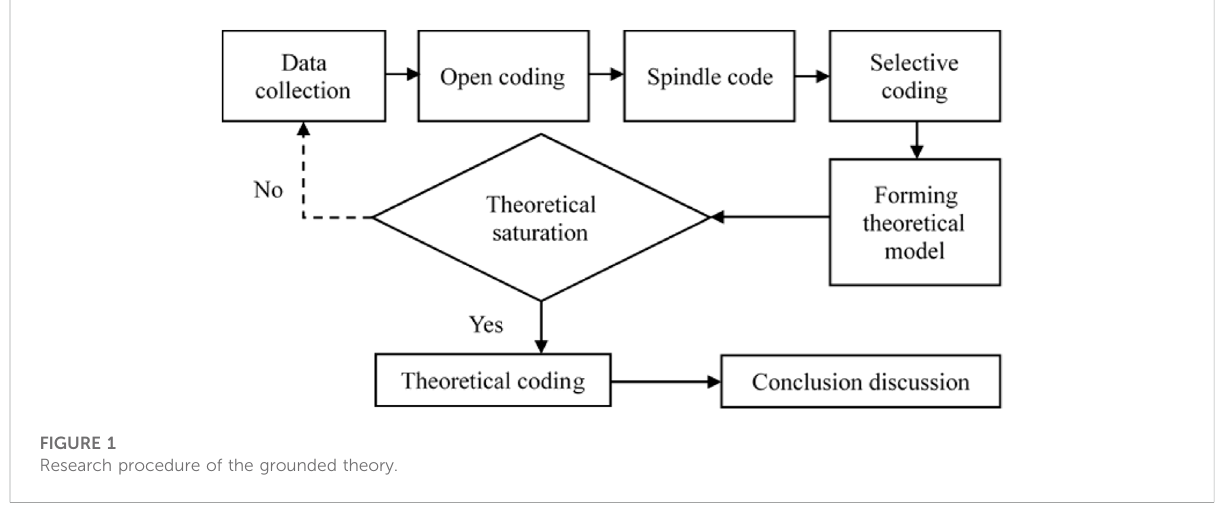
FIGURE 1 Research procedure of the grounded theory.